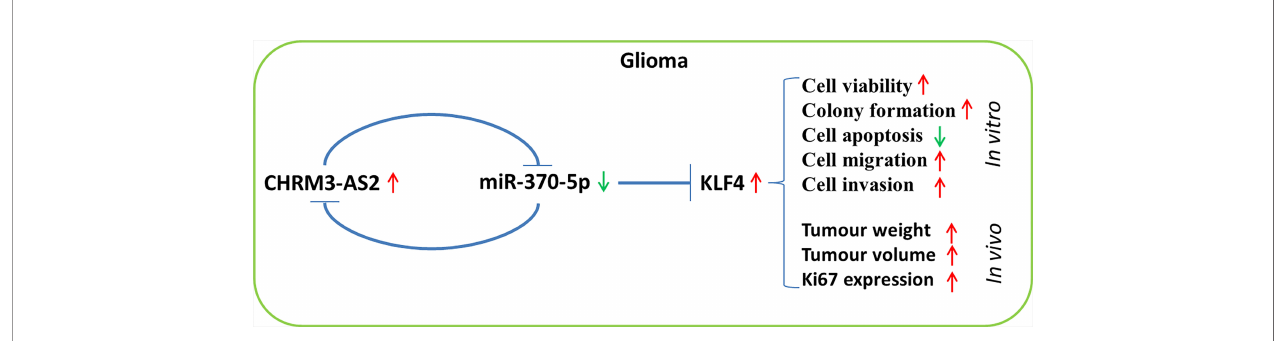
FIGURE 8 | A fl ow chart of the regulatory axis of CHRM3-AS2/miR-370-5p/KLF4 in